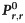
Detection rates against Pr,r0 for count communication data with |V| = 20 and two communities.P1,1′=(1+1.5)×P1,10.